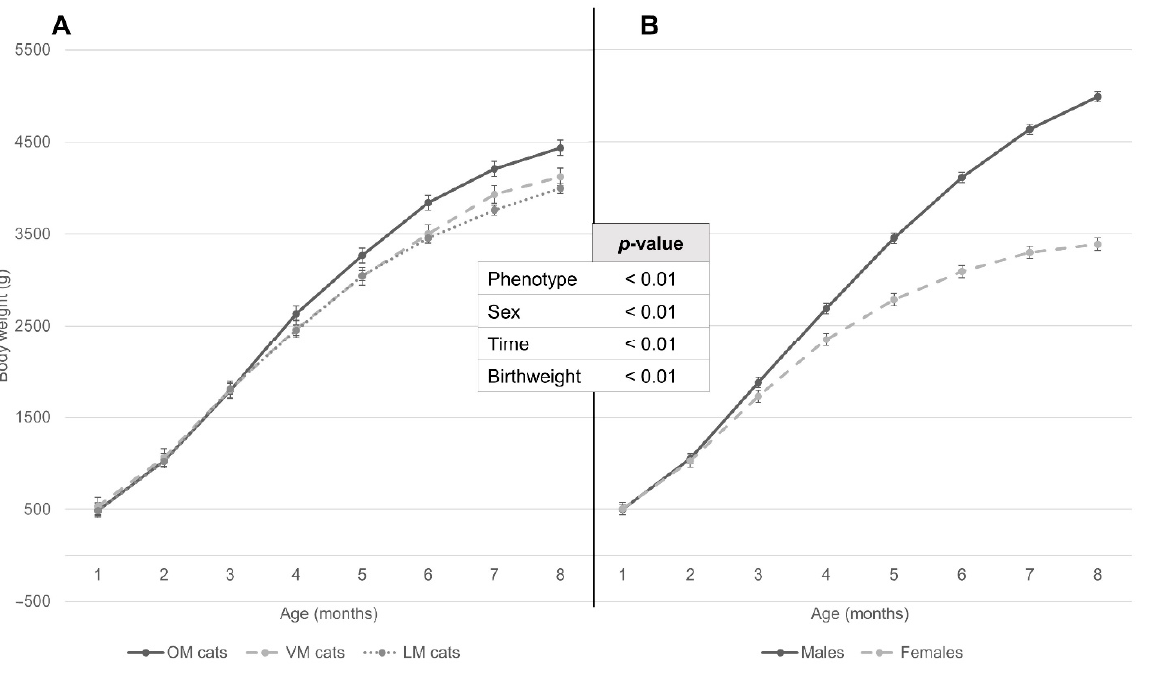
Figure 3. Least square means of total weight development from first to the eighth month of age, according to ( A ) maternal phenotype and ( B ) sex (data from repeated measures mixed model). Standard errors are depicted with brackets per month, for each group. p -values for each independent variable used in the repeated measures mixed model are specified in the central table. Both ( A ) and ( B ) are depicted according to the same scale. OM = maternal BCS always ≥ 6, VM = maternal BCS differing between < and ≥ 6, LM = maternal BCS always <6. Time significantly interacted with phenotype and sex (both p < 0.01).